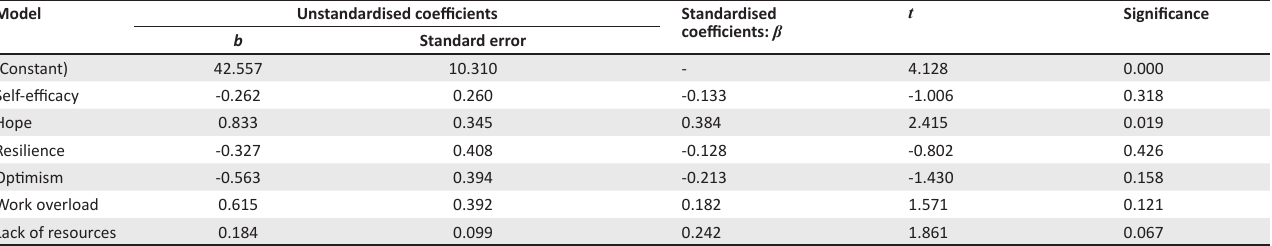
TABLE 6: Coefficients showing the relative contribution of each of the dimensions of psychological capital and job demands in predicting organisational commitment. Model Unstandardised coefficients Standardised coefficients: